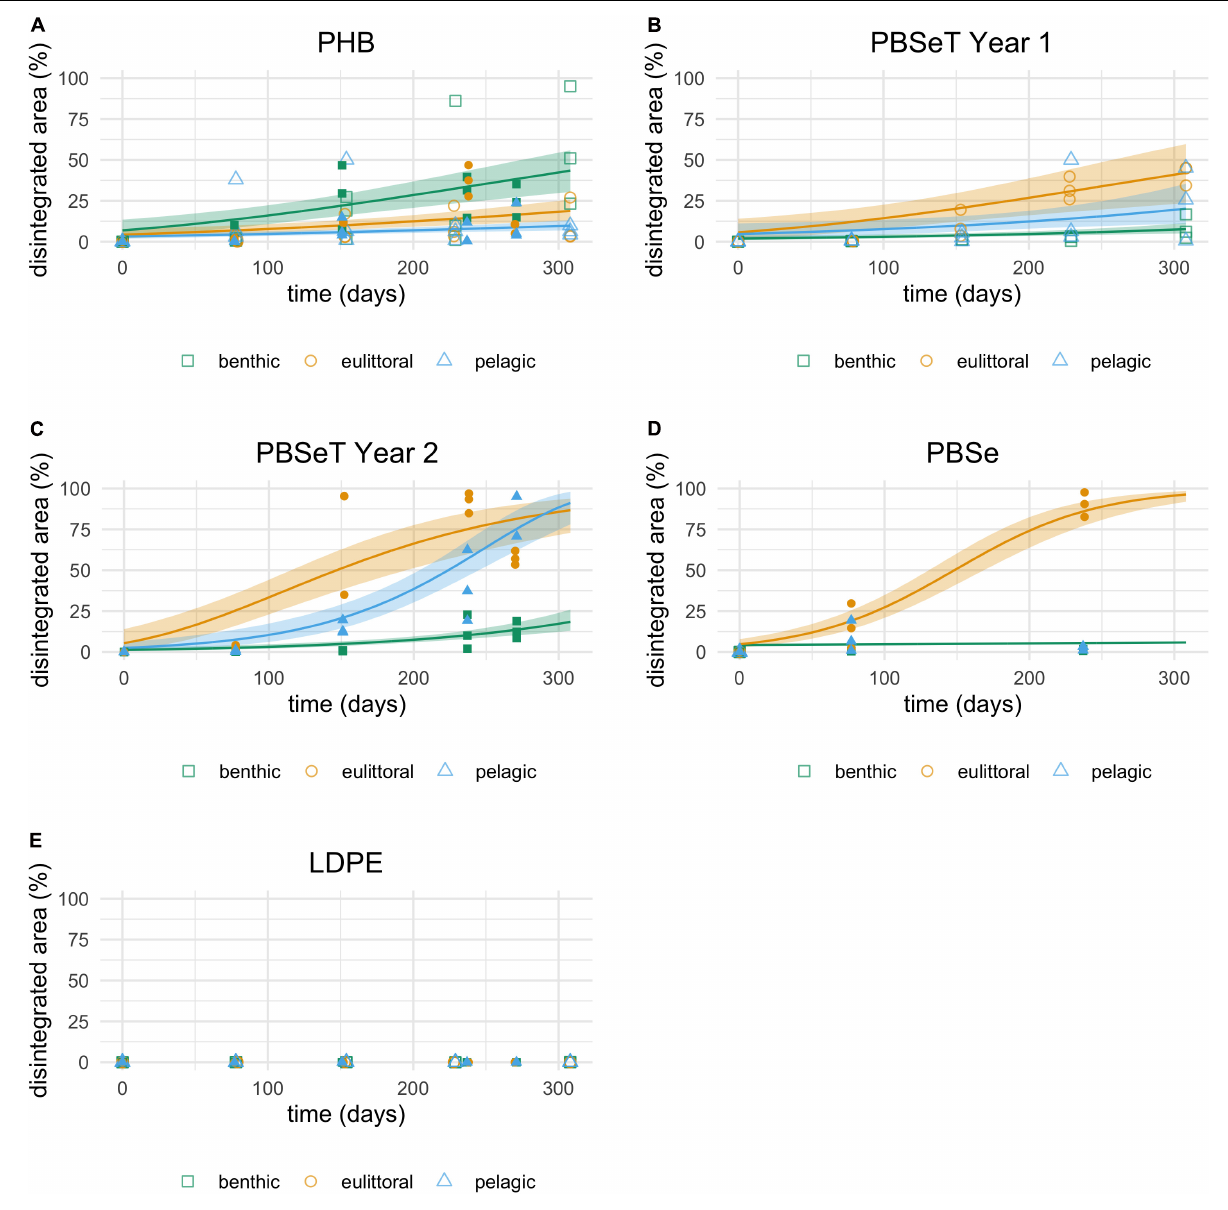
FIGURE 4 | Mesocosm experiments with Mediterranean Sea water and sediment: Disintegration curves of (A) PHB, (B) PBSeT, and (C) PBSe over 10 (year 1) and (D) 9 (year 2) months when exposed in the seafloor scenario at the sediment-seawater interface (benthic), in the water column (pelagic) scenario or buried in the intertidal sandy beach (eulittoral) scenario. (E) For LDPE no disintegration was measured. The model curve ± SE (shaded area) was drawn if the slope was different from zero and positive. Dots represent raw data analyzed in the model (open = year 1, filled = year 2), For PBSeT two significantly different model curves are shown. Colors represent the habitat (green = benthic, orange = eulittoral, blue =